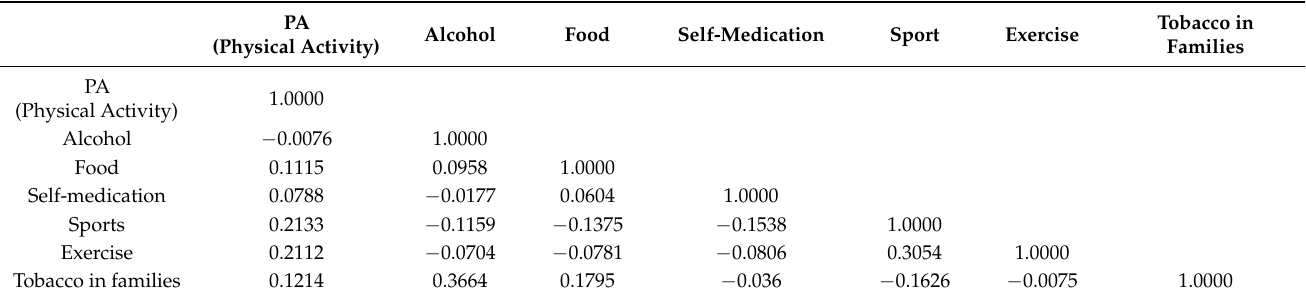
Table 3. The correlation matrix between the latent